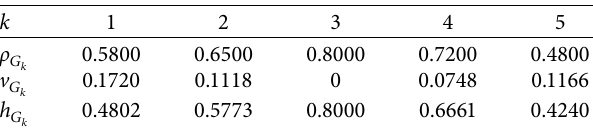
Table 3: .e computation results of the harmonious degree h ( k � 1, ... ,